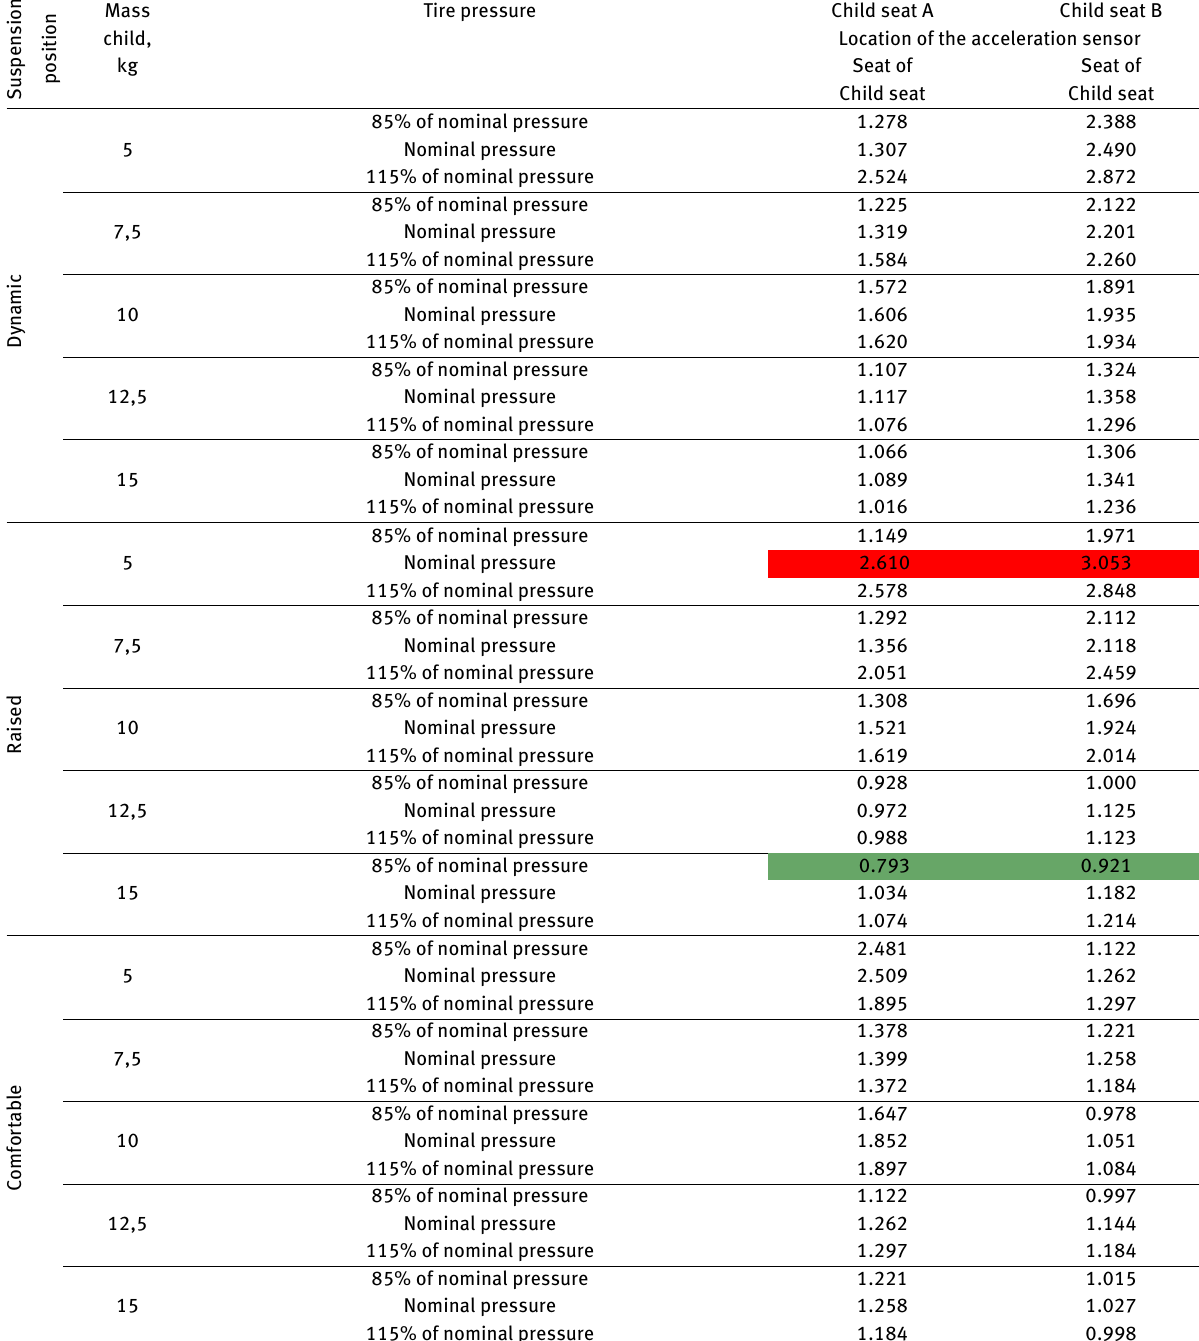
Table 2: Summary of RMS values for the tested child safety seats